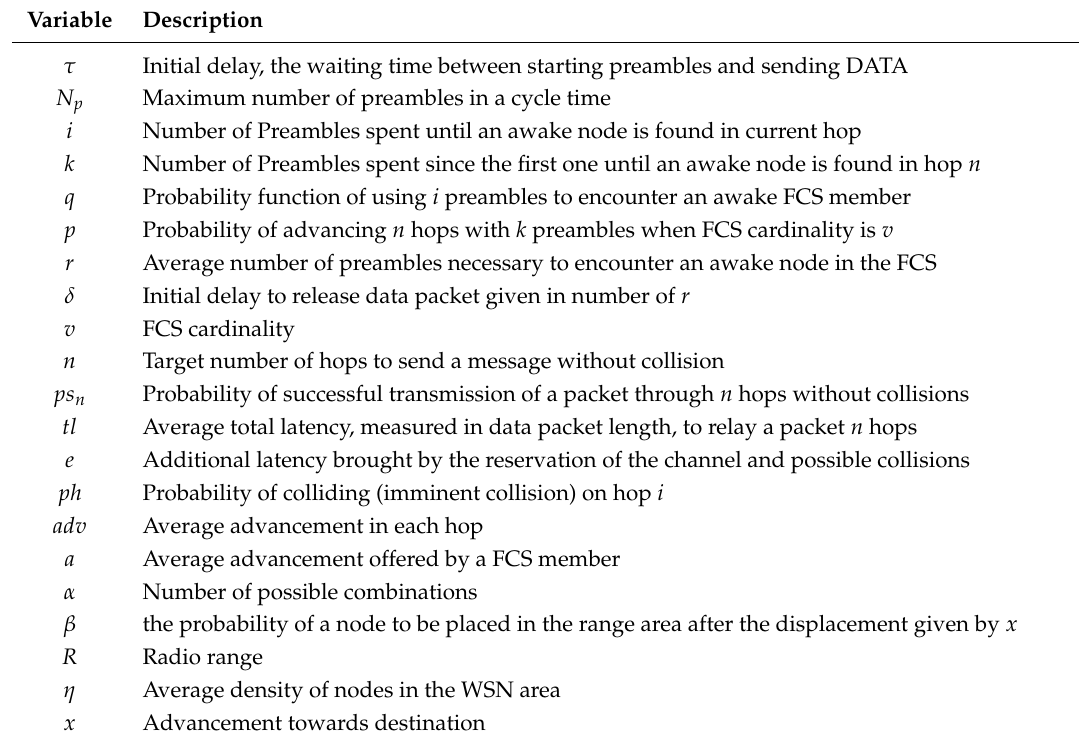
Table 3. List of all variables in the mathematical